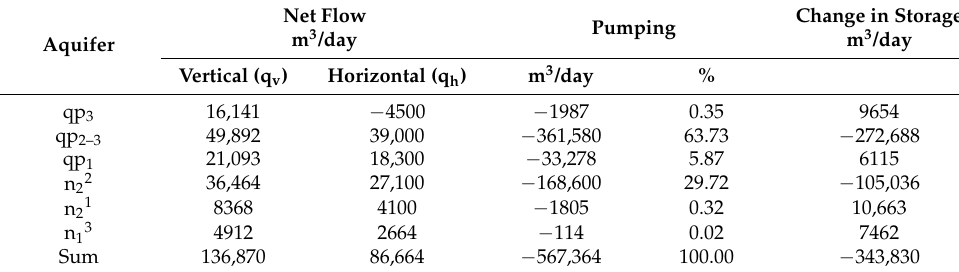
Table 5. Aquifer budget for different aquifers in December